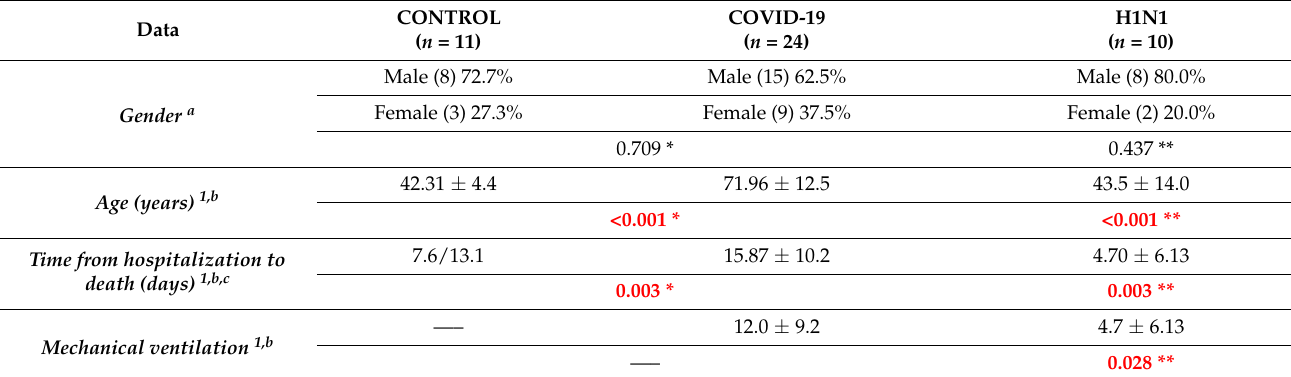
Table 1. Comparison between COVID-19, H1N1, and basal CONTROL groups according to clinical findings and pathology